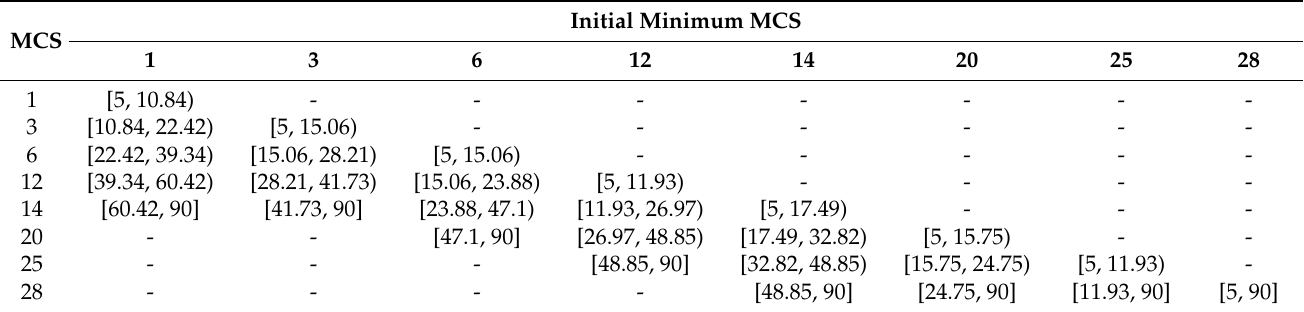
Table 6. Theoretical range of elevation angle corresponding to different MCS in VCM system ( ◦